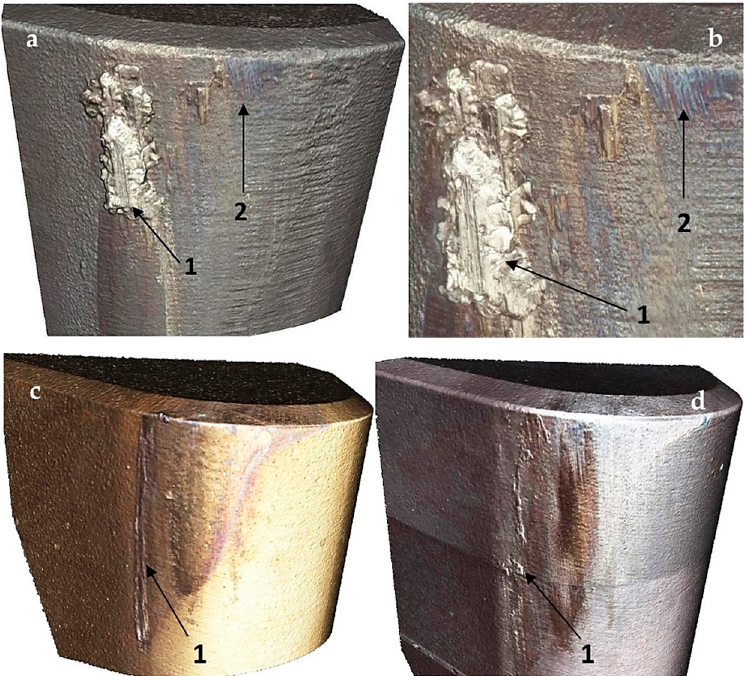
Figure 4. ( a , b ): T1 tool after machining with the feed value f 3 = 0.3 mm/rev., magnification 500×; 1—adhesive wear, 2—abrasive wear; T2 ( c ) and T3 ( d ) tool after machining with the feed value f 3 = 0.3 mm/rev., magnification 200×; 1—adhesive wear.